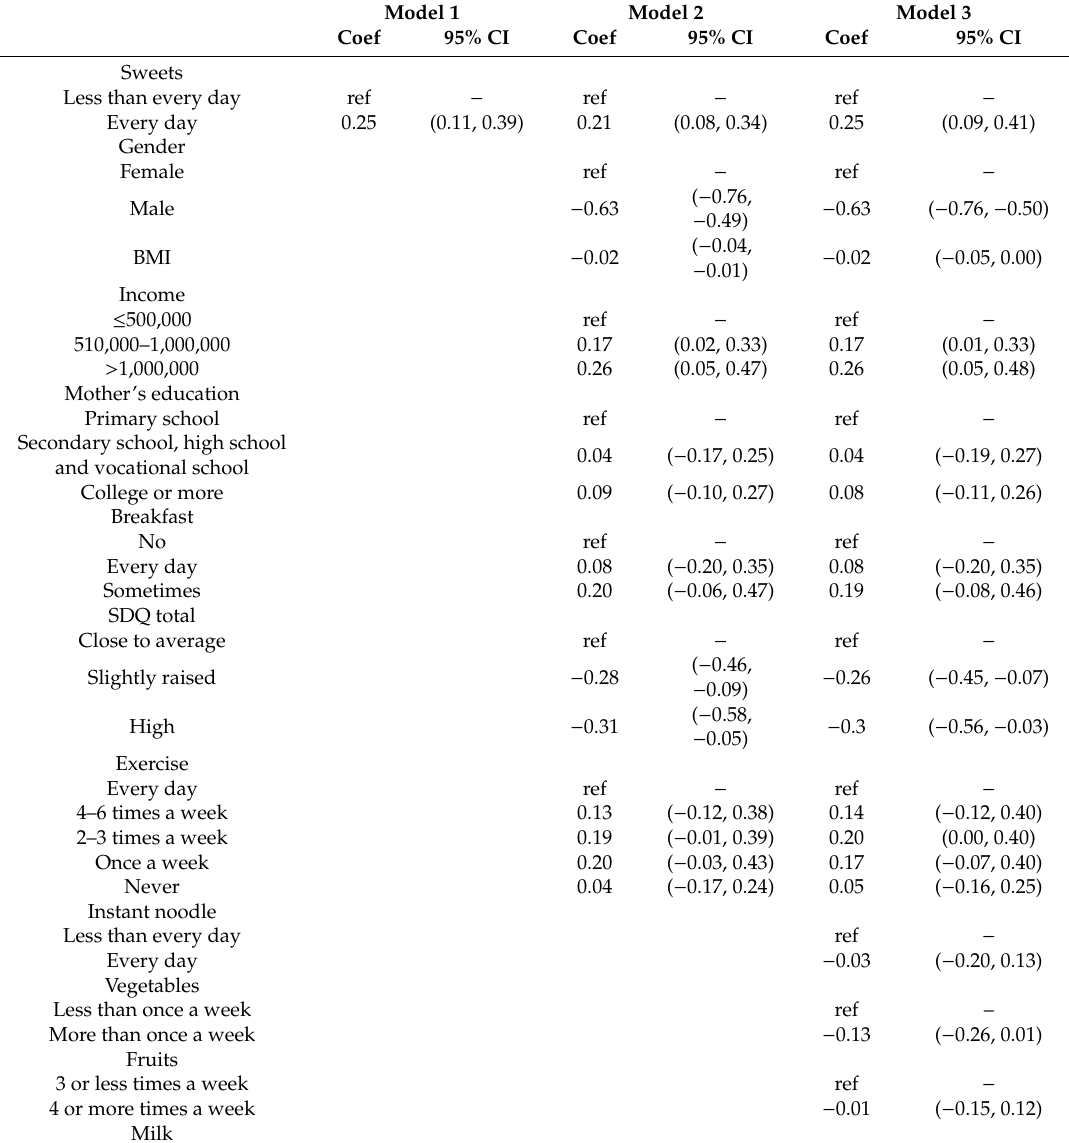
Table 3. Linear regression results for sociodemographic and dietary factors associated with academic performance in the Mongolian language; multiple imputation applied ( n =